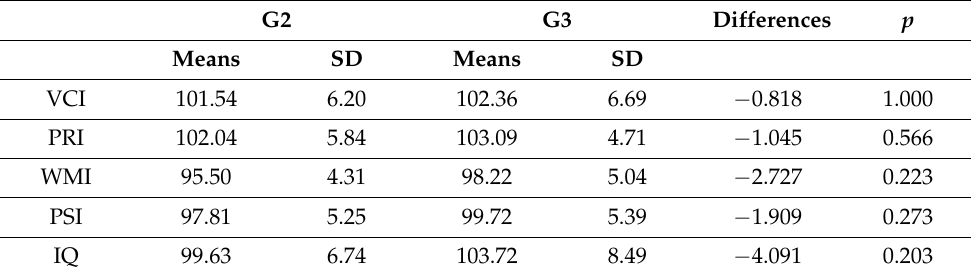
Table 4. Post Hoc Comparisons between Groups 2 and